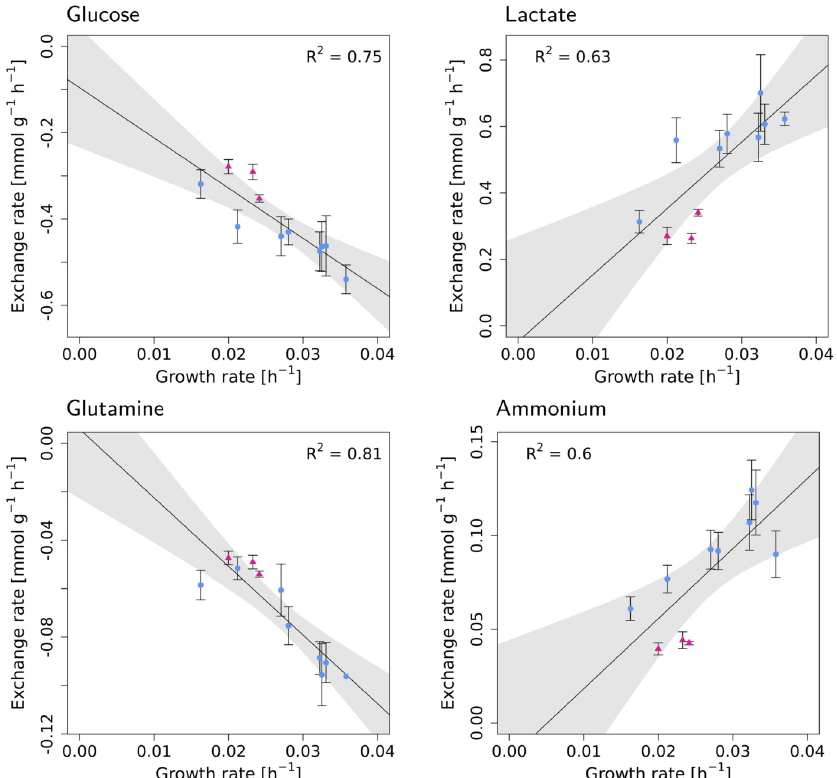
Fig 5. The experimental exchange rates of glucose (A), lactate (B), glutamine (C) and ammonium (D) increase with increasing growth rate. The shaded areas represent 95% confidence intervals. The triangle points in magenta color are the dilution rates that had unusually high cell concentration in steady state (see S7